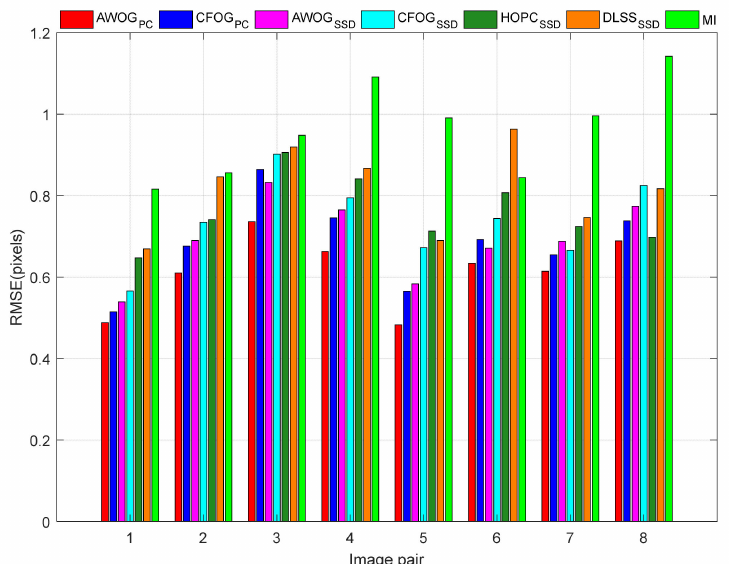
Figure 11. The RMSE results of all methods with a template window of 91 × 91